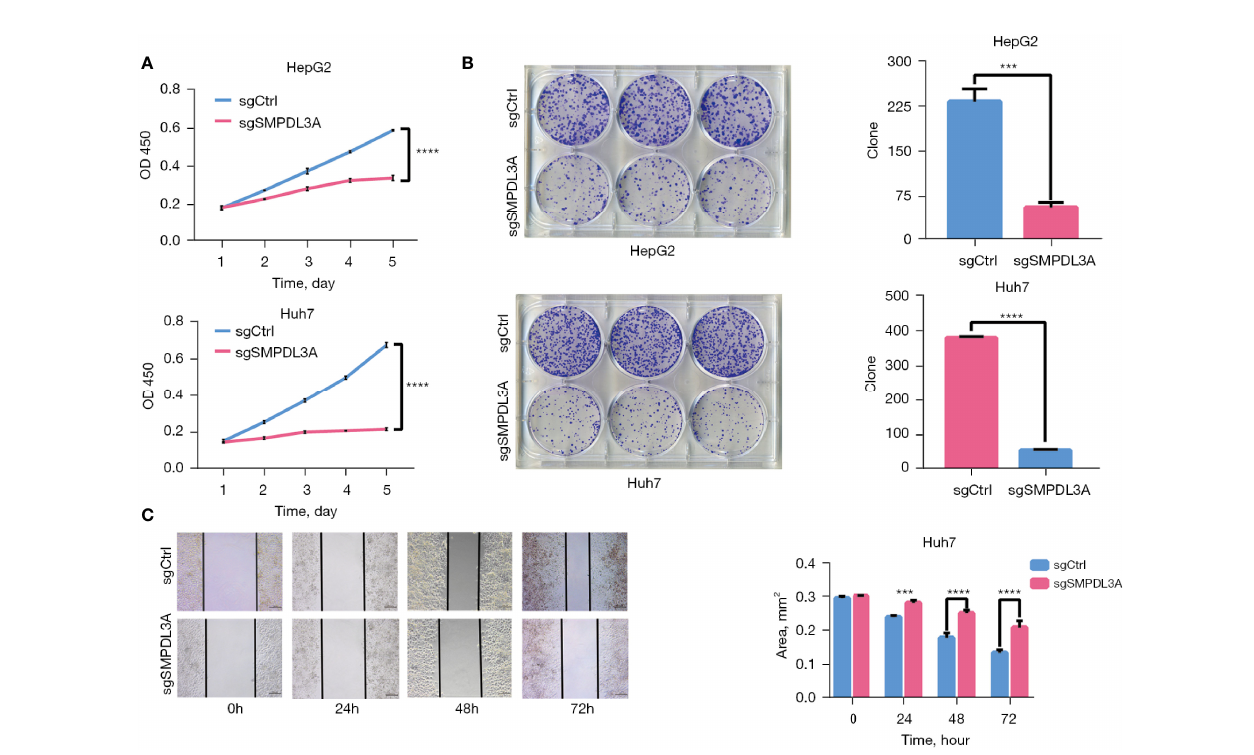
FIGURE 5 | SMPDL3A promotes HCC cell proliferation and migration in vitro . (A) The proliferation of HepG2 and Huh7 cells in the SMPDL3A knockout and control groups. SMPDL3A knockout HCC cell line proliferation was signi fi cantly lower than that in the control group (****P<0.0001). (B) The number of clones of HepG2 and Huh7 cells sgSMPDL3A was signi fi cantly lower than that in the control group (***P=0.0002, ****P<0.0001). (C) Huh7 cell wound healing (scratches) in the sgSMPDL3A and control groups at 0, 24, 48, and 72h (***P=0.0005,